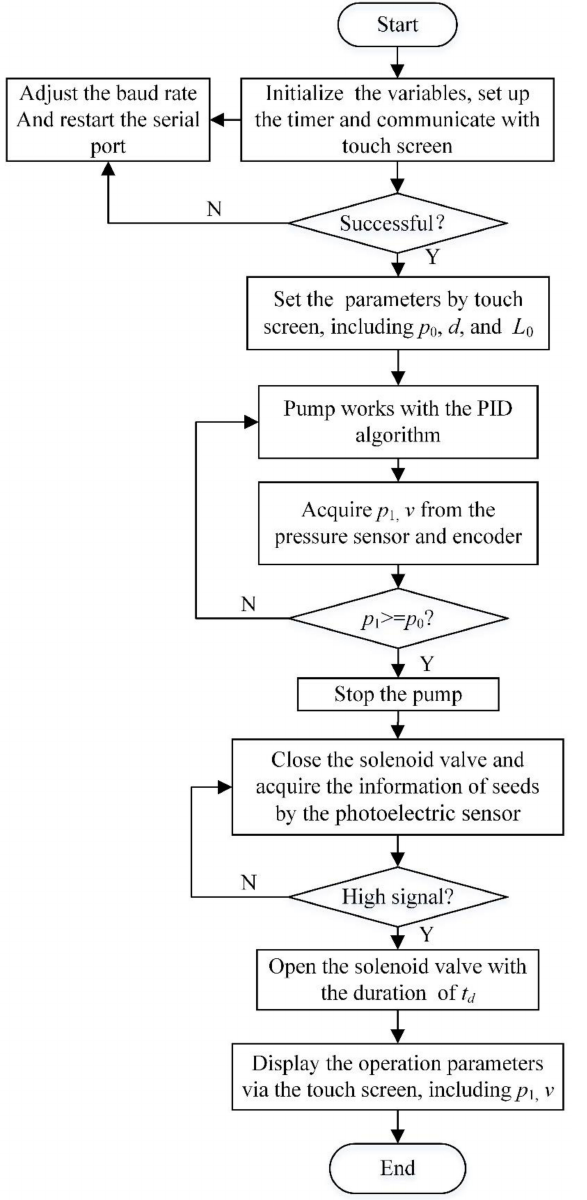
Figure 5. Algorithm flow chart of the detection control